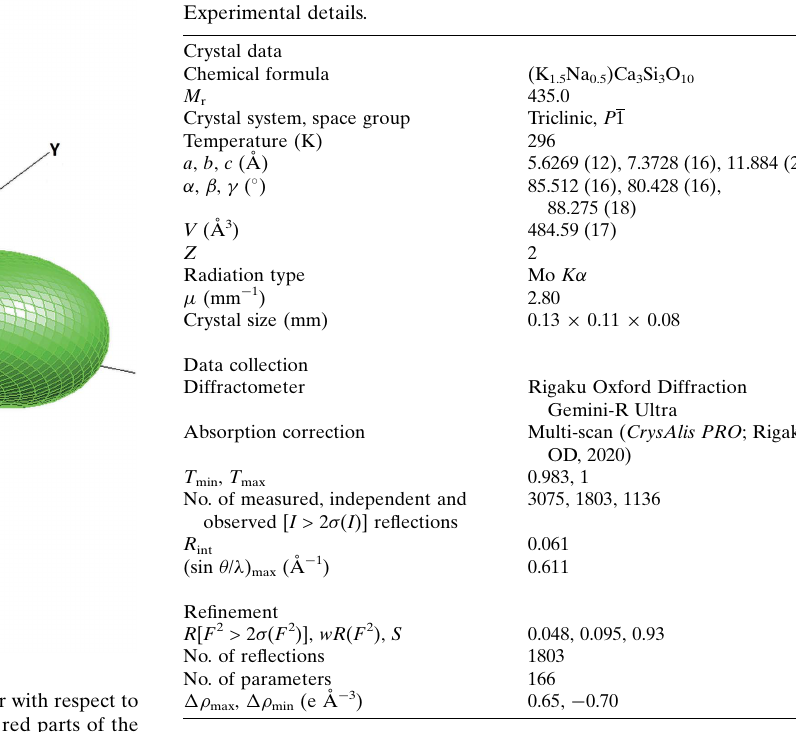
: (75.1 (cid:2) ; 53.7 (cid:2) ; 1 : (156.7 (cid:2) ; 68.0 (cid:2) ; 96.9 (cid:2) ). 3